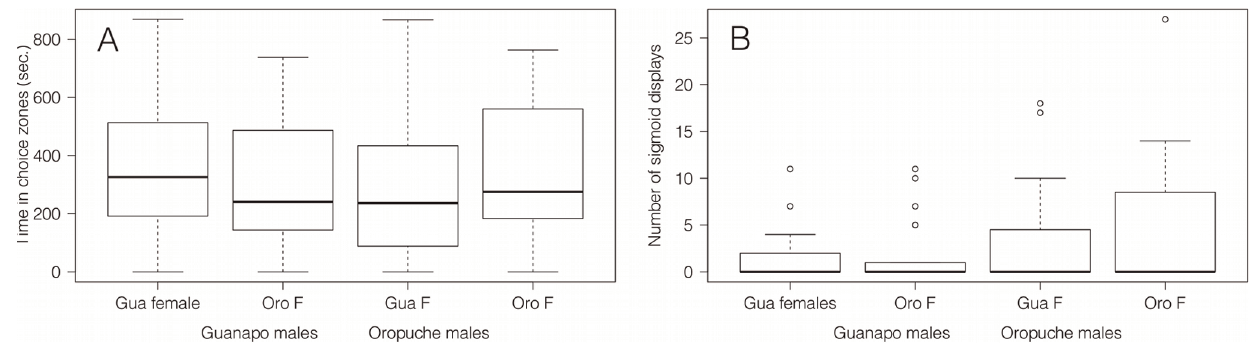
Figure 3. Male mate choice. The time focal males from the Guanapo and Oropuche spent in the choice zones with a set of females from either their own or the other population (a) and the number of sigmoid displays they directed towards these females (b). Medians interquartile ranges and outliers are shown.